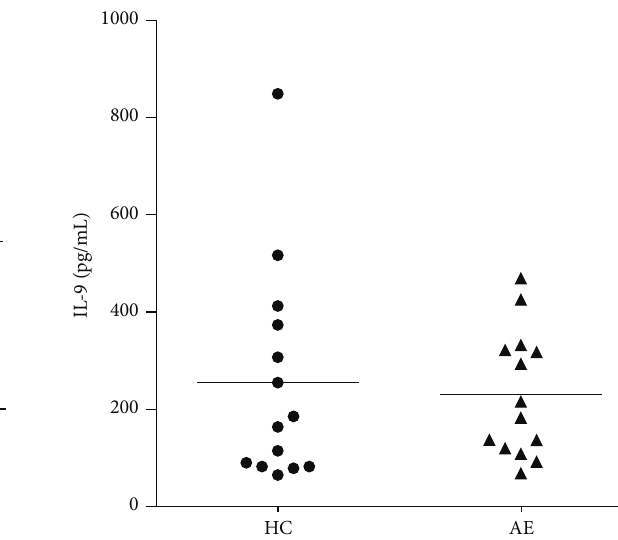
Figure3:TheplasmaIL-9concentrationlevelsinAEandHCgroup. IL-9 concentrations in AE group were slightly lower than those in HC group, and there was no statistical significance found between the two groups ( 𝑃 > 0.05 ). HC: healthy control; AE: alveolar